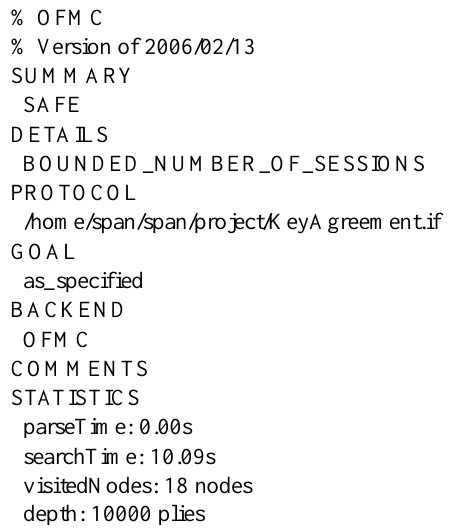
Figure 6. HLPSL script for the SP and SM for their basic role.